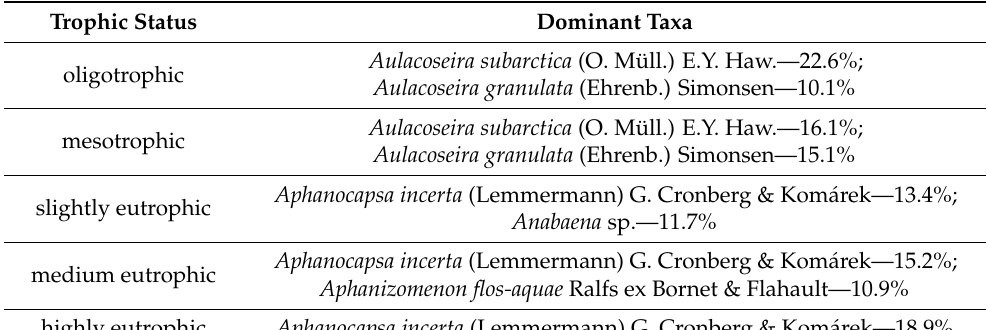
Table 2. Dominant taxa of phytoplankton in different trophic